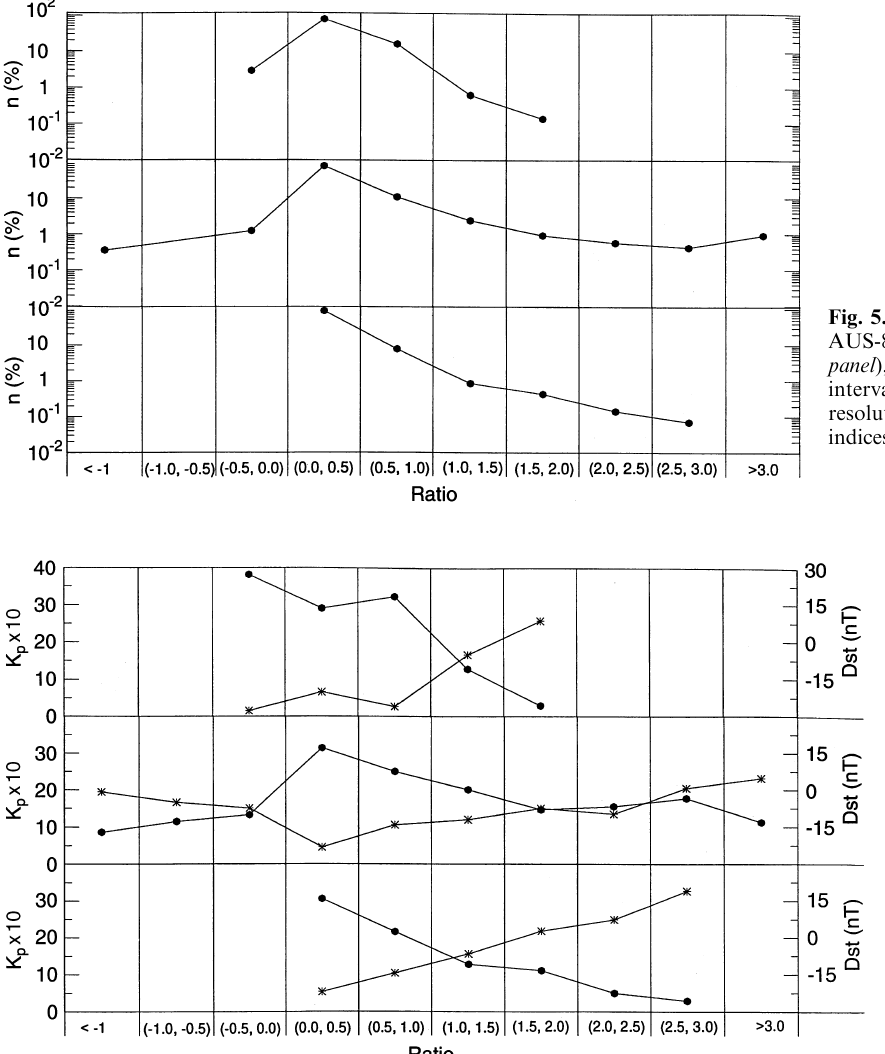
Fig. 6. Average value for Kp ( d ) and Dst (*) for the groups of data binned into the same AUS-80/AU ( top panel ), ALS-80/AL ( middle panel ) and AES-80 / AE ( bottom panel ) ratio ranges as in